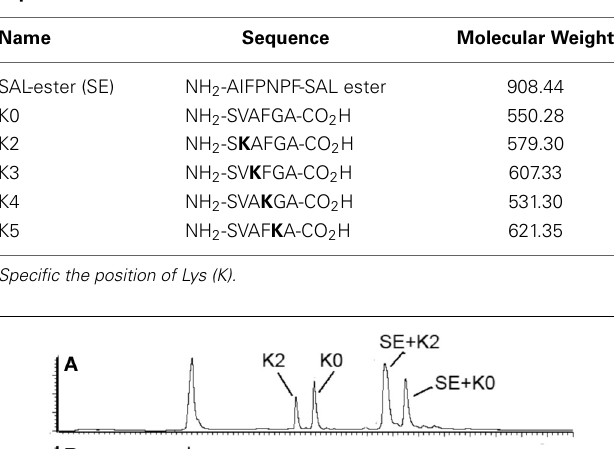
Table 1 | Sequence of model peptides used in competitive